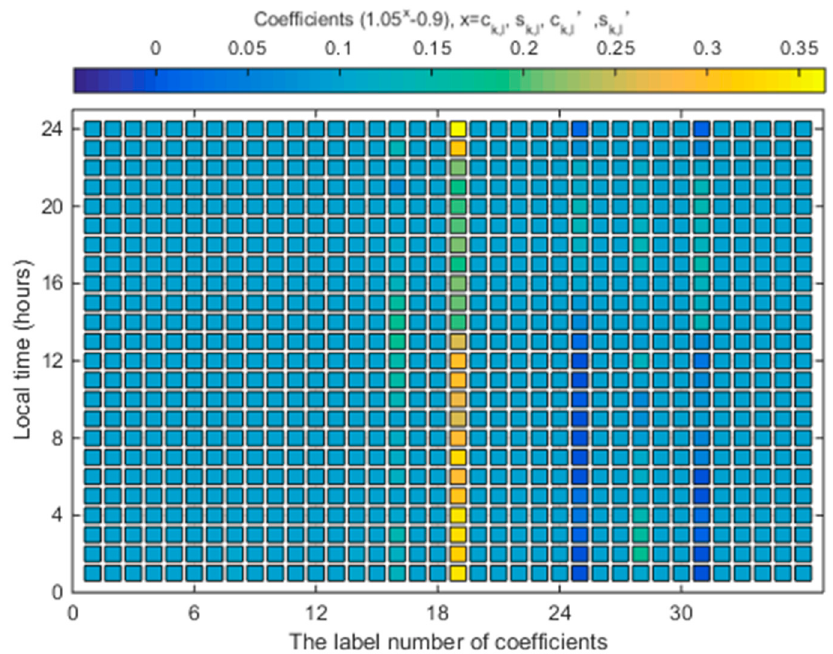
Figure 7. Sample of temporal reconstructed coefficients at 00:00 UT at Kokubunji station. The label number from 1 to 36 represent the coefficients c 0,0 , c 0,1 , c 0,2 , s 0,0 , s 0,1 , s 0,2 , c 1,0 , c 1,1 , c 1,2 , s 1,0 , s 1,1 , s 1,2 , c 2,0 , c 2,1 , c 2,2 , s 2,0 , s 2,1 , s 2,2 , c ′ 0,0 , c ′ 0,1 , c ′ 0,2 , s ′ 0,0 , s ′ 0,1 , s ′ 0,2 , c ′ 1,0 , c ′ 1,1 , c ′ 1,2 , s ′ 1,0 , s ′ 1,1 , s ′ 1,2 , c ′ 2,0 , c ′ 2,1 , c ′ 2,2 , s ′ 2,0 , s ′ 2,1 , and s ′ 2,2 , respectively.